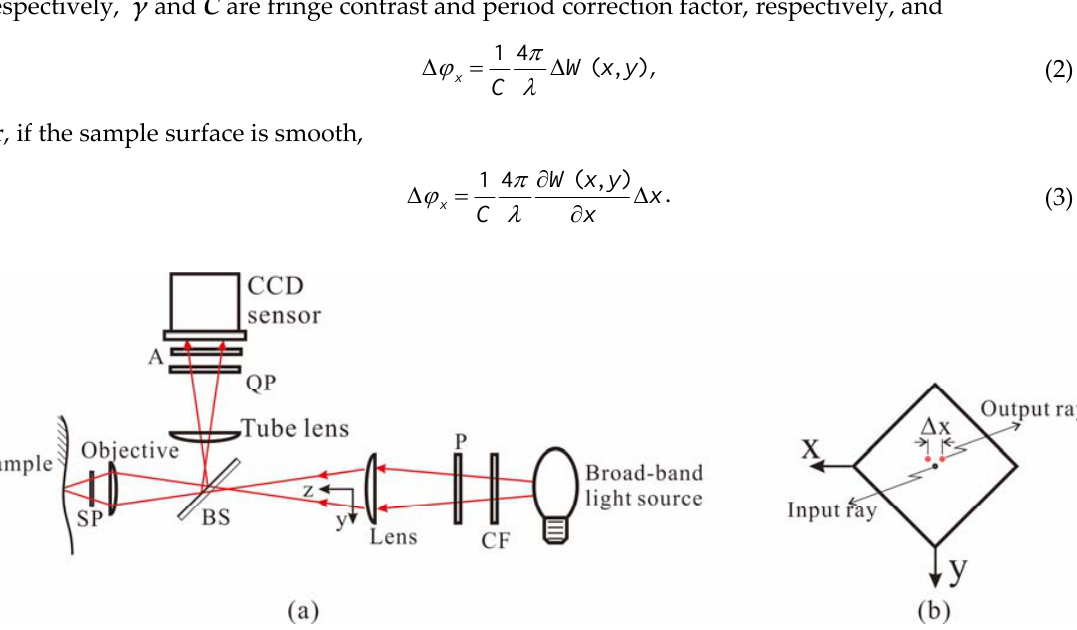
Figure 1. ( a ) Apparatus of the proposed microscope; ( b ) left side view of SP. Where CF: color filter, P: polarizer with its transmission axis parallel to the x ‐ axis, BS: beam ‐ splitter, SP: Savart prism, QP: quarter ‐ wave plate with its fast ‐ axis parallel to the x ‐ axis, A: analyzer with its transmission axis at angle  α measured from the x ‐ axis and rotation axis parallel to the z ‐